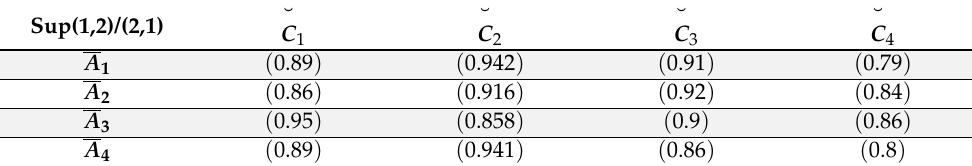
Table 4. Decision matrix of calculated support values established from Tables 1 and 2.